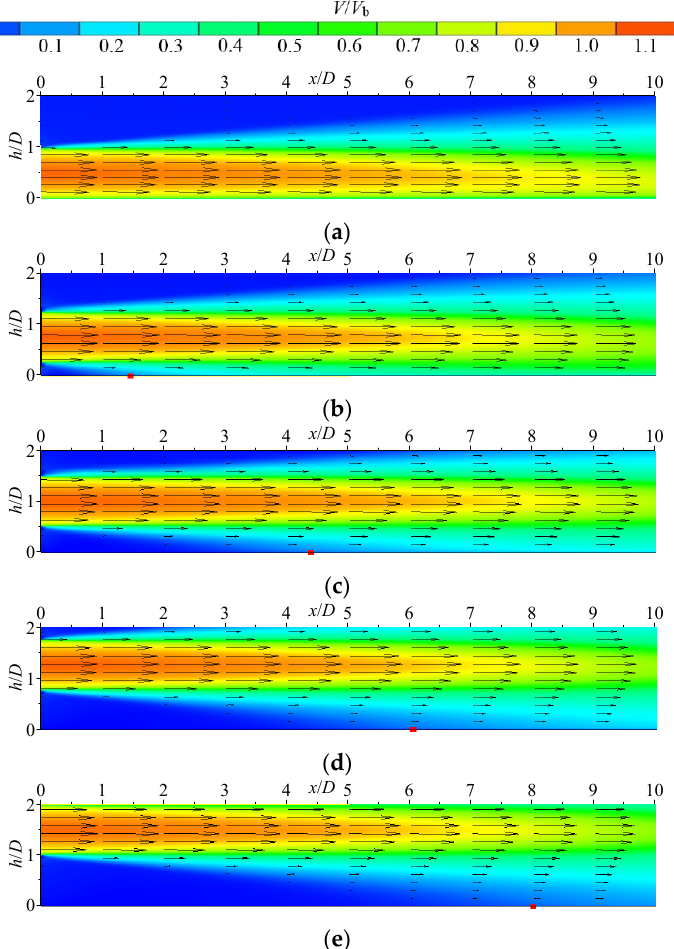
Figure 14. Contours with vector diagrams of jet velocity distribution at different incidence heights H / D : ( a ) H / D = 0.5; ( b ) H / D = 0.75; ( c ) H / D = 1; ( d ) H / D = 1.25; and ( e ) H / D = 1.5.